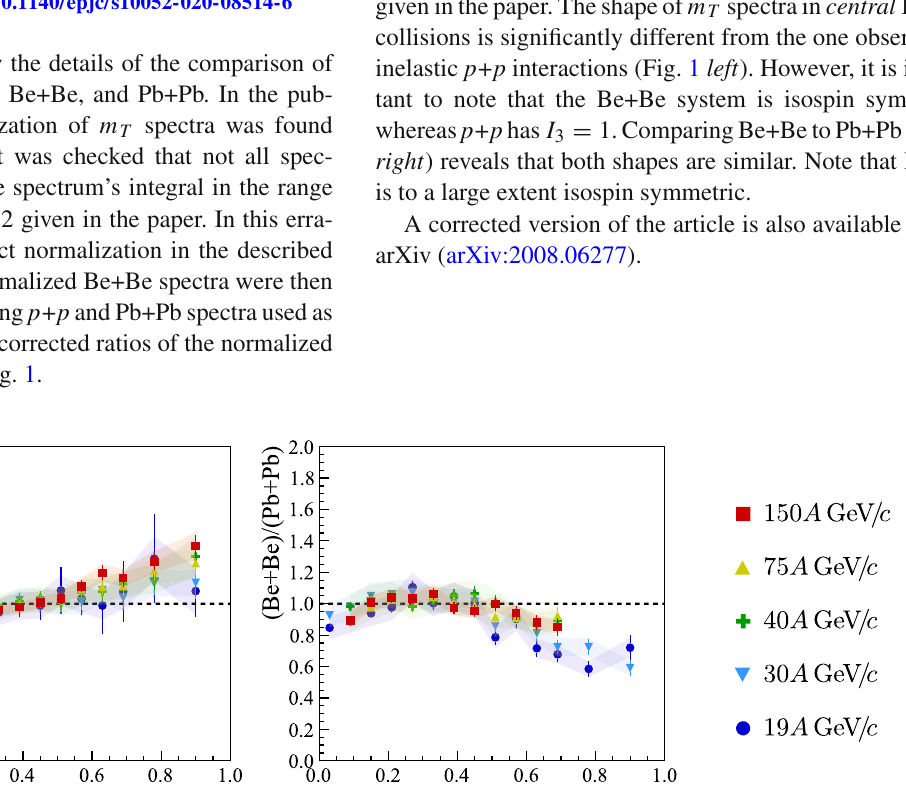
The original article can be found online at https://doi.org/10.1140/